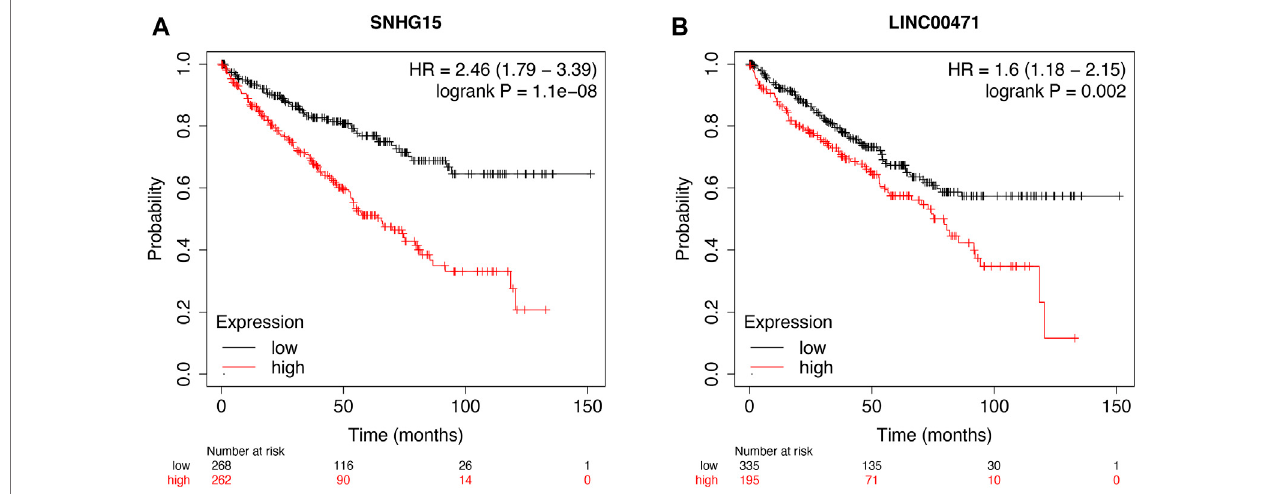
FIGURE 12 | Expression levels of cuproptosis-associated lncRNAs in paired tumor tissues. RT-qPCR was used to measure the expression of SNHG15 and LINC00471 in paired tumor tissues (A , B) .